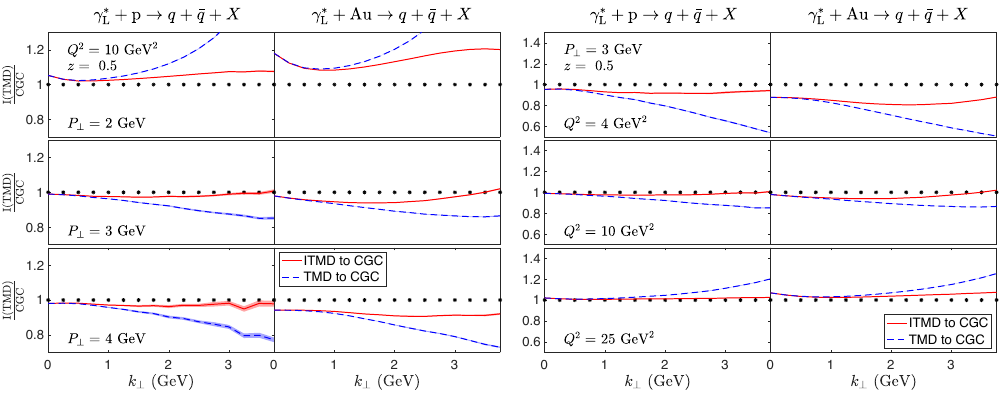
Figure 5 . Top: differential yield (averaged over azimuthal angles φ P quark anti-quark pair in γ ∗ to the CGC.